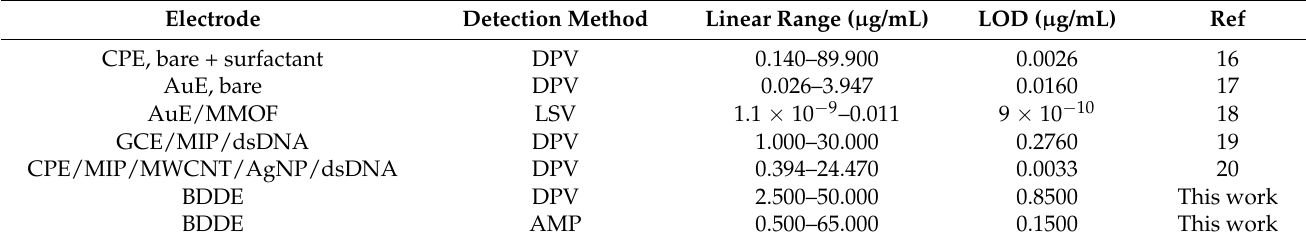
Table 1. Comparison of the analytical parameters of different GMB detection methods reported in the literature.